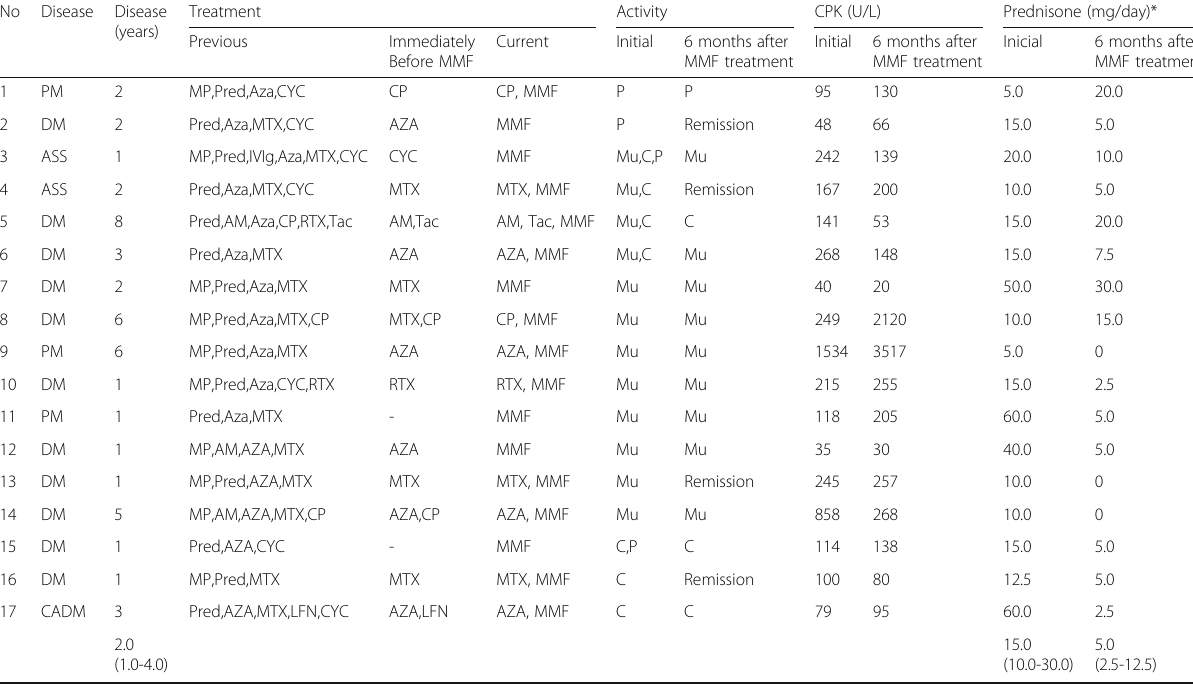
Table 1 General features of 17 refractory idiopathic systemic autoimmune myopathies No Disease Disease (years)